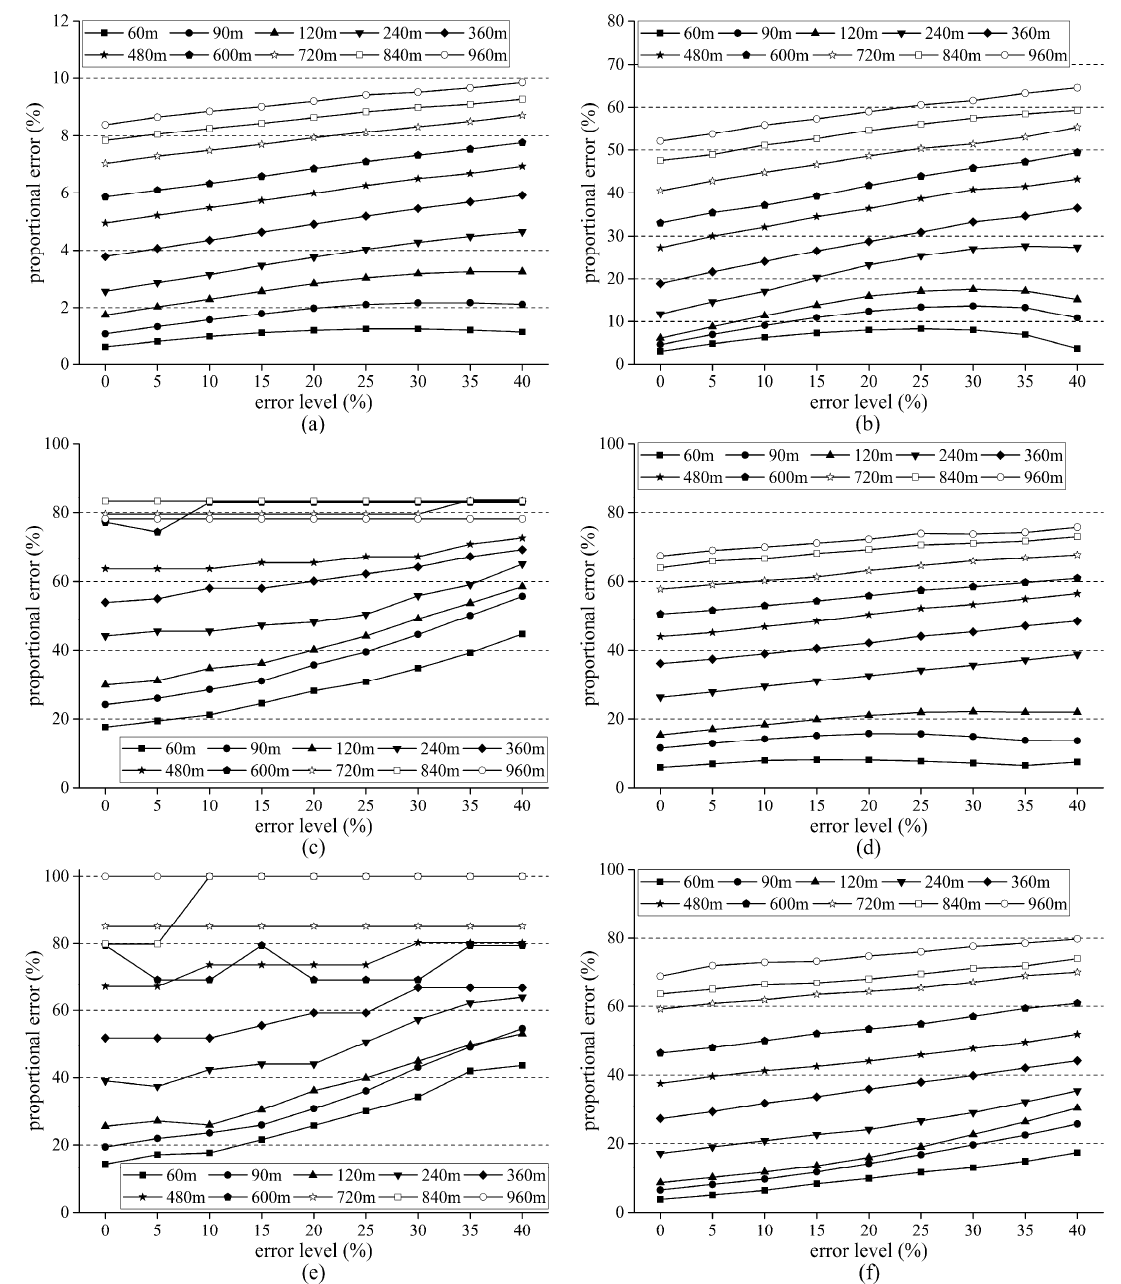
Figure 7. Changes in PE for each crop type at different resolutions with increasing base map error at ASD4550: ( a – f ) PEs of the non-crop, corn, sorghum, soybeans, winter wheat, and cotton, respectively.